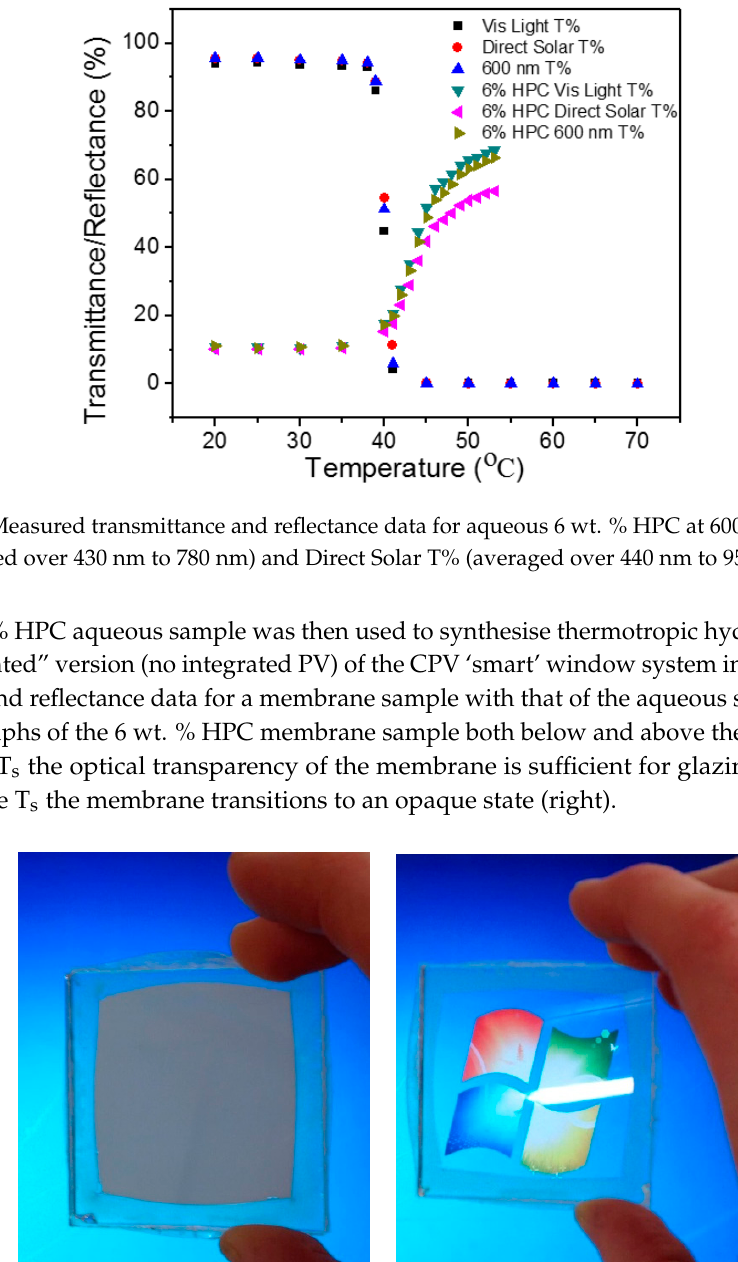
Figure 11. Photograph of 6 wt. % HPC membrane heated above the T s ( left ) and below the T s ( right